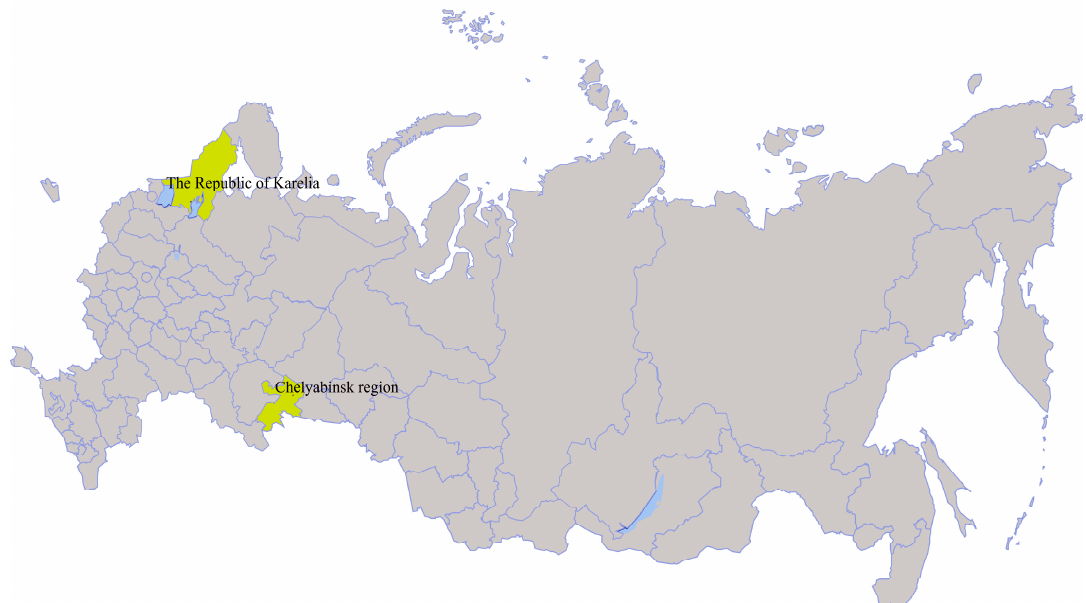
Figure 1. In 2014 from the beginning of May to the middle of June, nymphs and adult Ixodes persulcatus ticks were collected by flagging from vegetation in the Republic of Karelia and the Chelyabinsk region in Russian